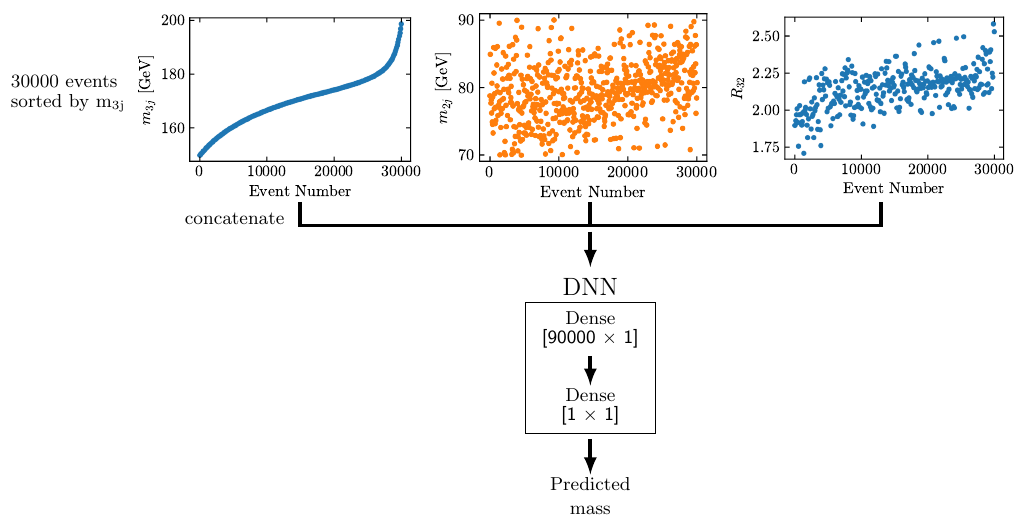
Figure 5. Example DNN and its inputs. Example inputs are m 3 j , m 2 j , and R 32 for 30,000 events, sorted according to increasing m 3 j